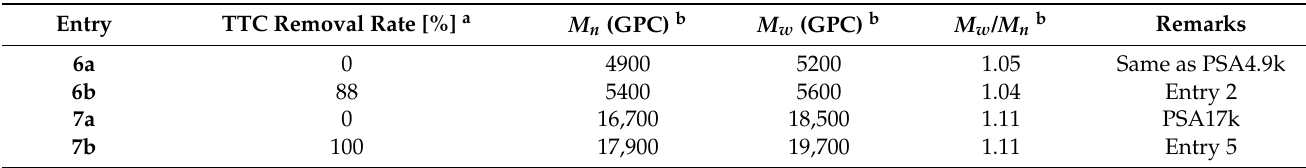
Table 3. SEC value for PSAs.